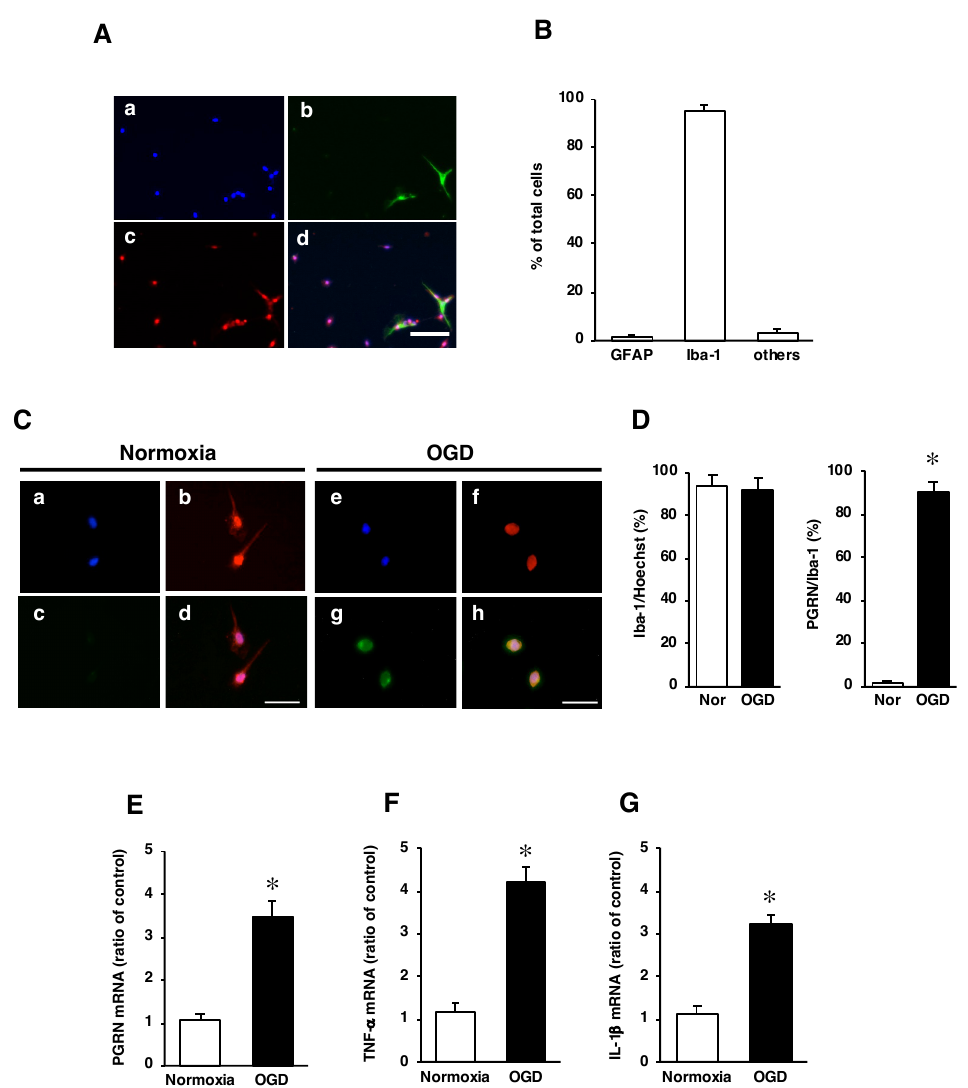
Figure 2. ( A ) Cortical cells fixed at 20 days in vitro and triple stained (merge, d) with glial fibrillary acidic protein (GFAP) (green, b) and Iba-1 (red, c), and Hoechst 33342 (blue, a). The scale bar represents 100 µm; ( B ) the numbers of GFAP- and Iba-1-positive cells were counted. The results are expressed as the percentage of these cells among the total number of Hoechst-positive cells and as the means ± SD ( n = 7 independent experiments); ( C ) images of triple staining (merge, d and h) with Hoechst 33342 (blue, a and e), Iba-1 (red, b and f), and PGRN (green, c and g) under Normoxia (a–d) or OGD (e–h) treatment. The scale bar represents 30 µm; ( D ) the numbers of Iba-1- and PGRN-positive cells under normoxia (Nor) or OGD were counted. Five images were made per experiment, and 26–100 cells were counted per image, and the average of 5 images per experiment was calculated. The results are expressed as the percentage of these cells among the total number of Hoechst-positive cells (Iba-1/Hoechst) and that of Iba-1-positive cells (PGRN/Iba-1), and as the means ± SD ( n = 9 independent experiments; the total number of Hoechst-positive cells counted: 2223 under normoxia and 2244 under OGD). *Significant difference from the normoxic group ( p < 0.05); ( E ) Effects of Normoxia or OGD exposure on the expression of PGRN mRNA in microglia. The results are expressed as the mean ratio of the Normoxia or OGD to the control group ± SD ( n = 8 independent experiments). * Significant difference from the normoxic group ( p < 0.05); ( F , G ) Effects of Normoxia or OGD exposure on the expression levels of TNF-α ( F ) and IL-1β ( G ) mRNA in microglia. The results are expressed as the mean ratio of the Normoxia or OGD to the control group ± SD ( n = 8 independent experiments). *Significant difference from the normoxic group ( p < 0.05).